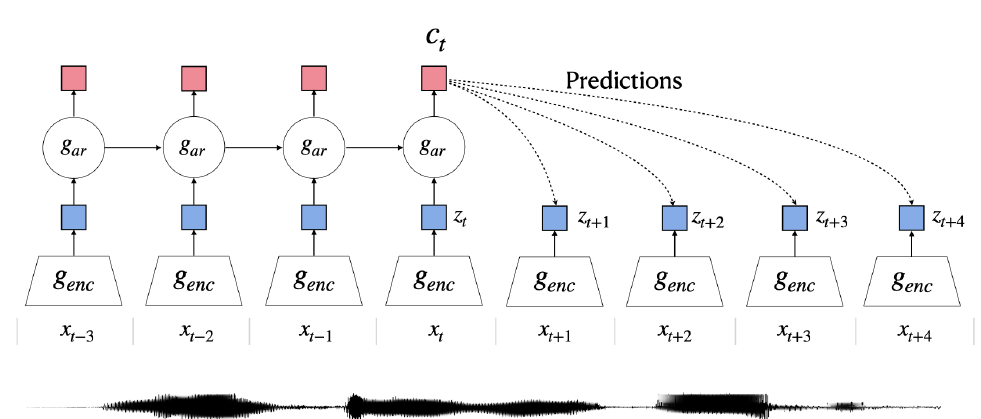
Figure 1. Overview of Contrastive Predictive Coding, audio as